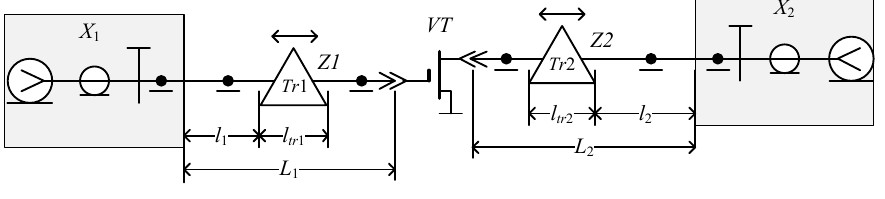
Fig. 6. Scheme of the contact